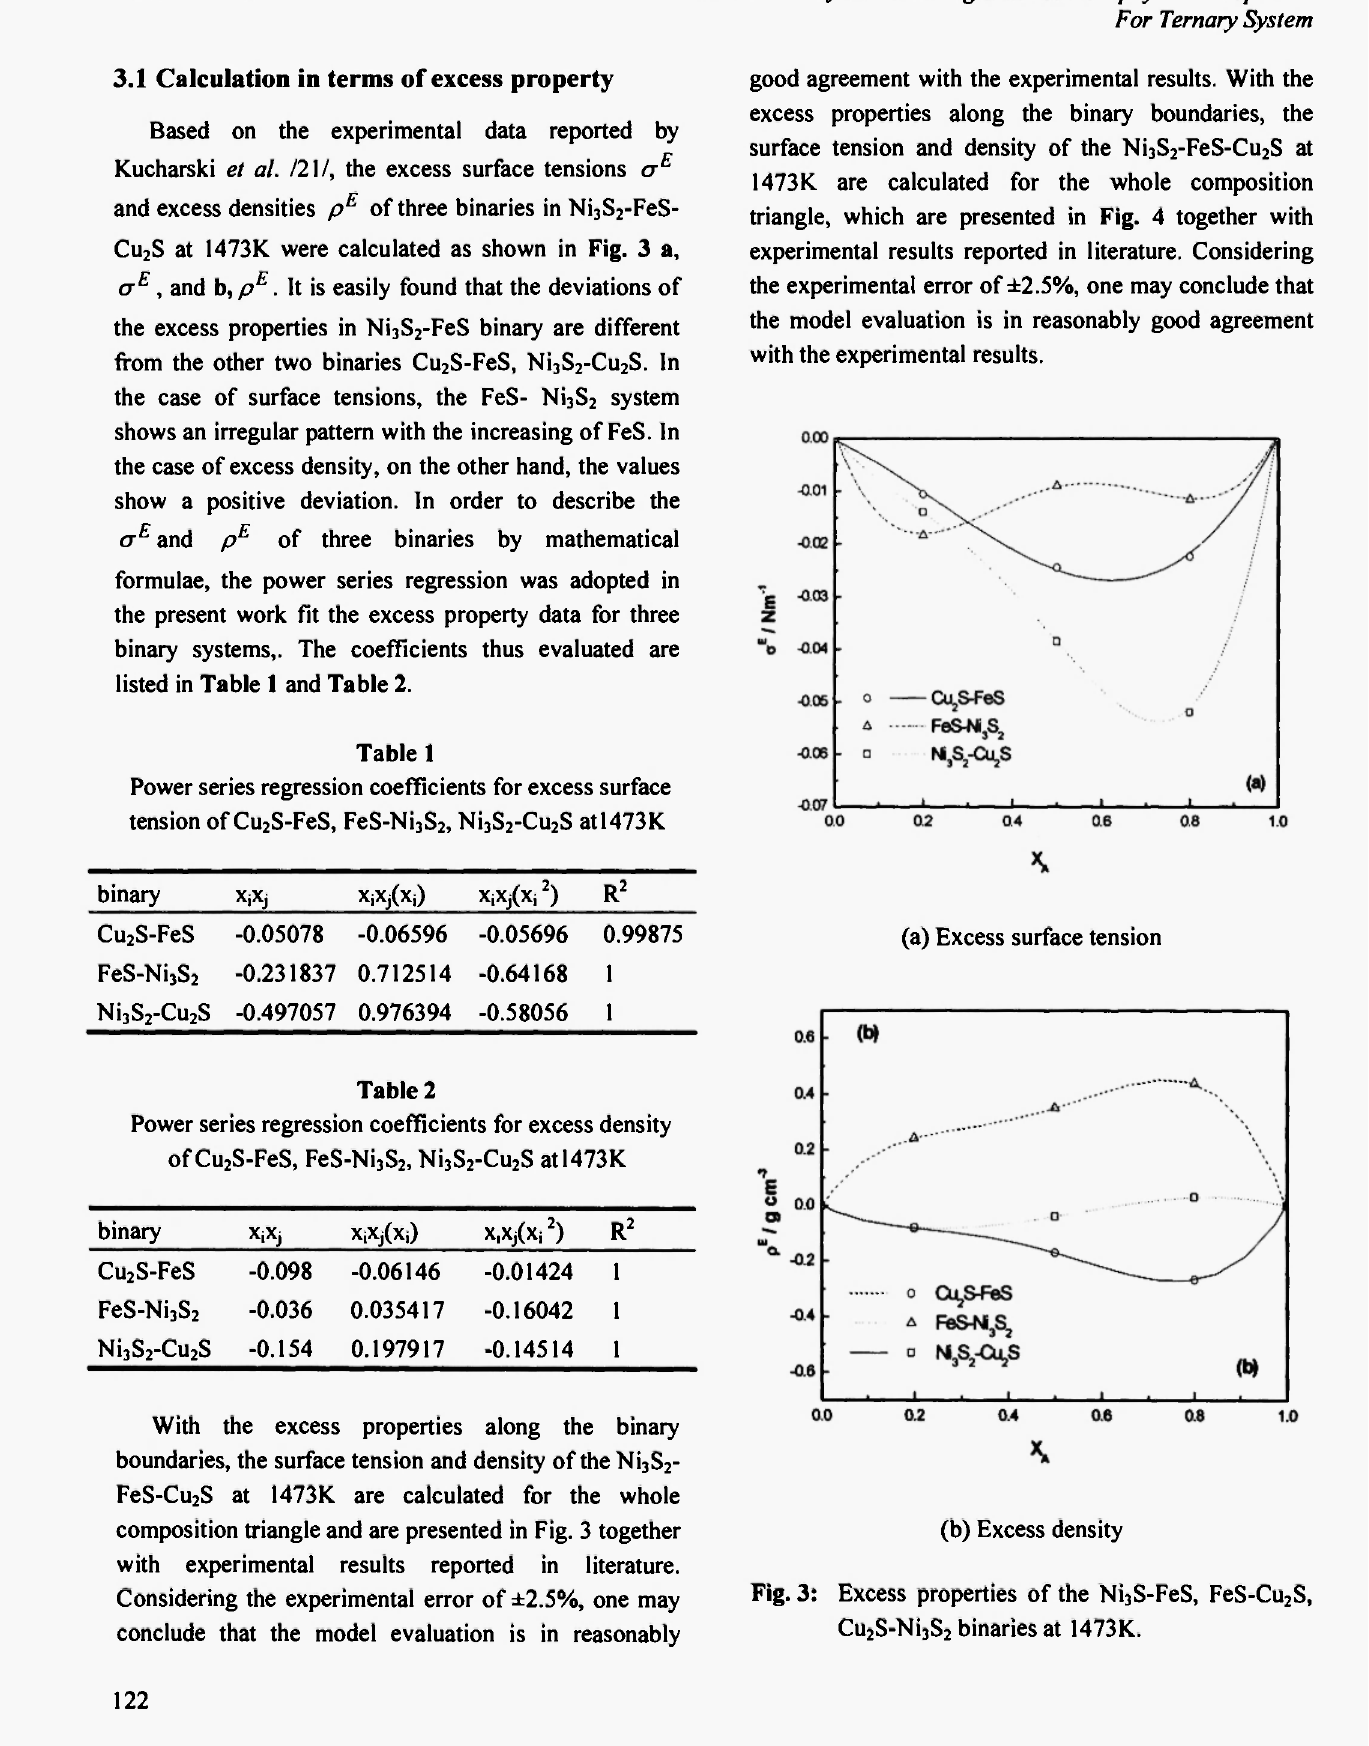
Power series regression coefficients for excess density